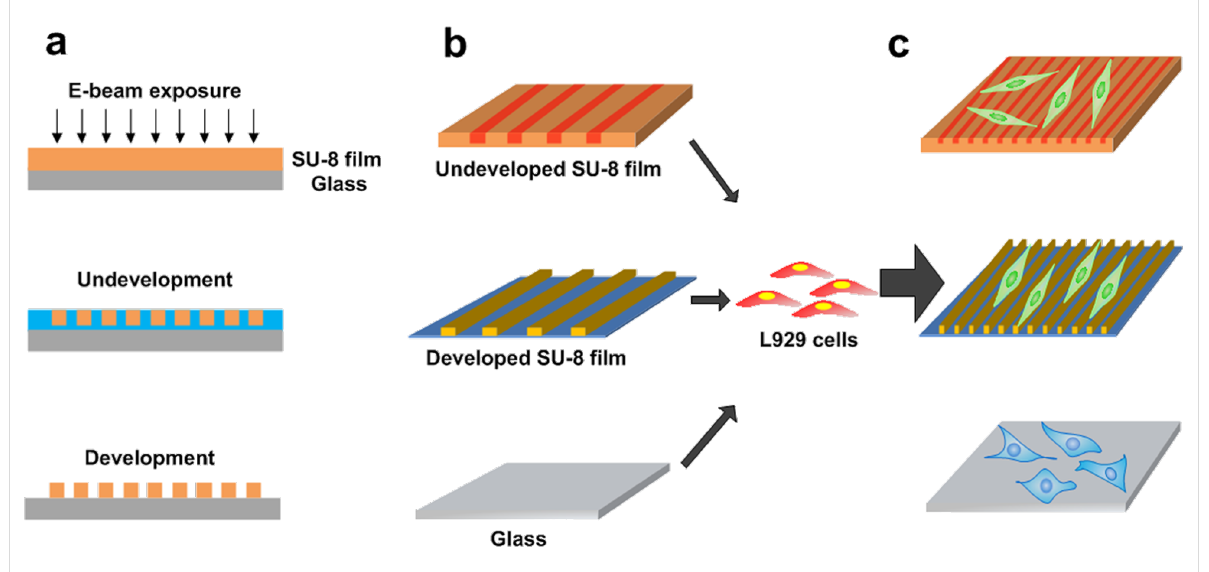
Figure 1: Fabrication of SU-8 films and differentiation of L929 cells cultured on the surfaces. (a) The fabrication process for producing tunable stiff- ness and topography substrates. (b) The undeveloped and developed SU-8 films and the reference glass substrate. (c) The changes in cellular be- havior in response to the different